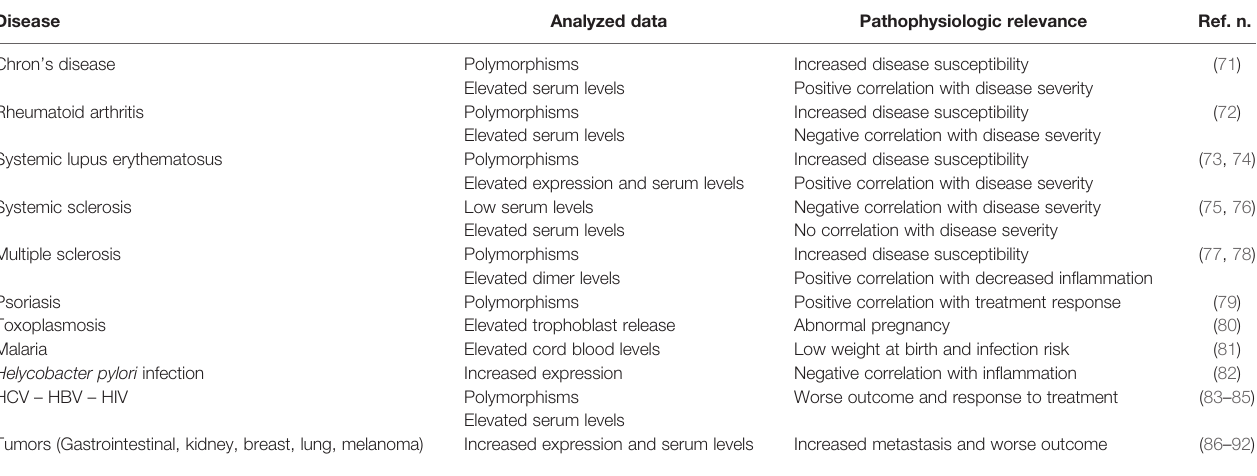
TABLE 2 | HLA-G in non-allergic diseases.